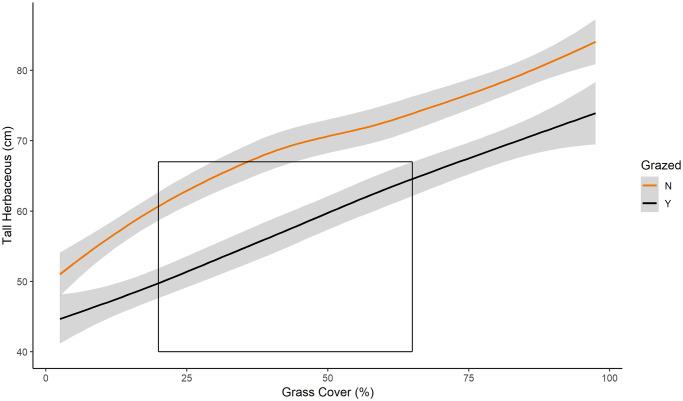
Vegetation height vs percent grass.Maximum height(cm) of herbaceous vegetation related to percent cover of grasses in fire-only (orange) and pyric herbivory (black) treatments at all sites from 2014 to 2016. Area within box represents the minimum and maximum recommended parameters for suitable nesting cover for prairie-chickens from primary literature. Shaded area indicates 95% confidence interval. *Regression lines and confidence intervals generated using “loess” locally-weighted smoothing function.